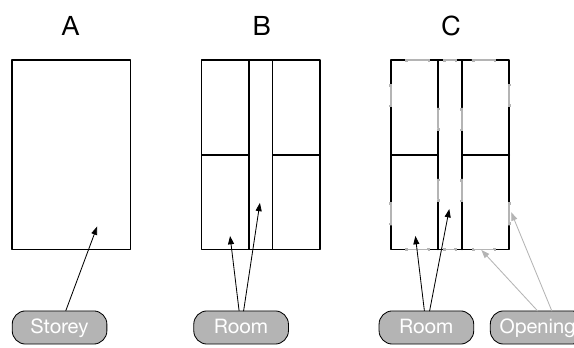
Figure 4. Example object graph of one storey and one room each with a 2D surface and a 2D curve representation with 3D volume representation, the SpaceBoundary type ad- heres to features with 2D surface representation. These are con- nected such that Space type features are bounded by Space- Boundary type features. Consequently, in LoD0, Space type fea- tures are represented as surfaces (projected volumes) and their space boundaries as curves (projected vertical surfaces).